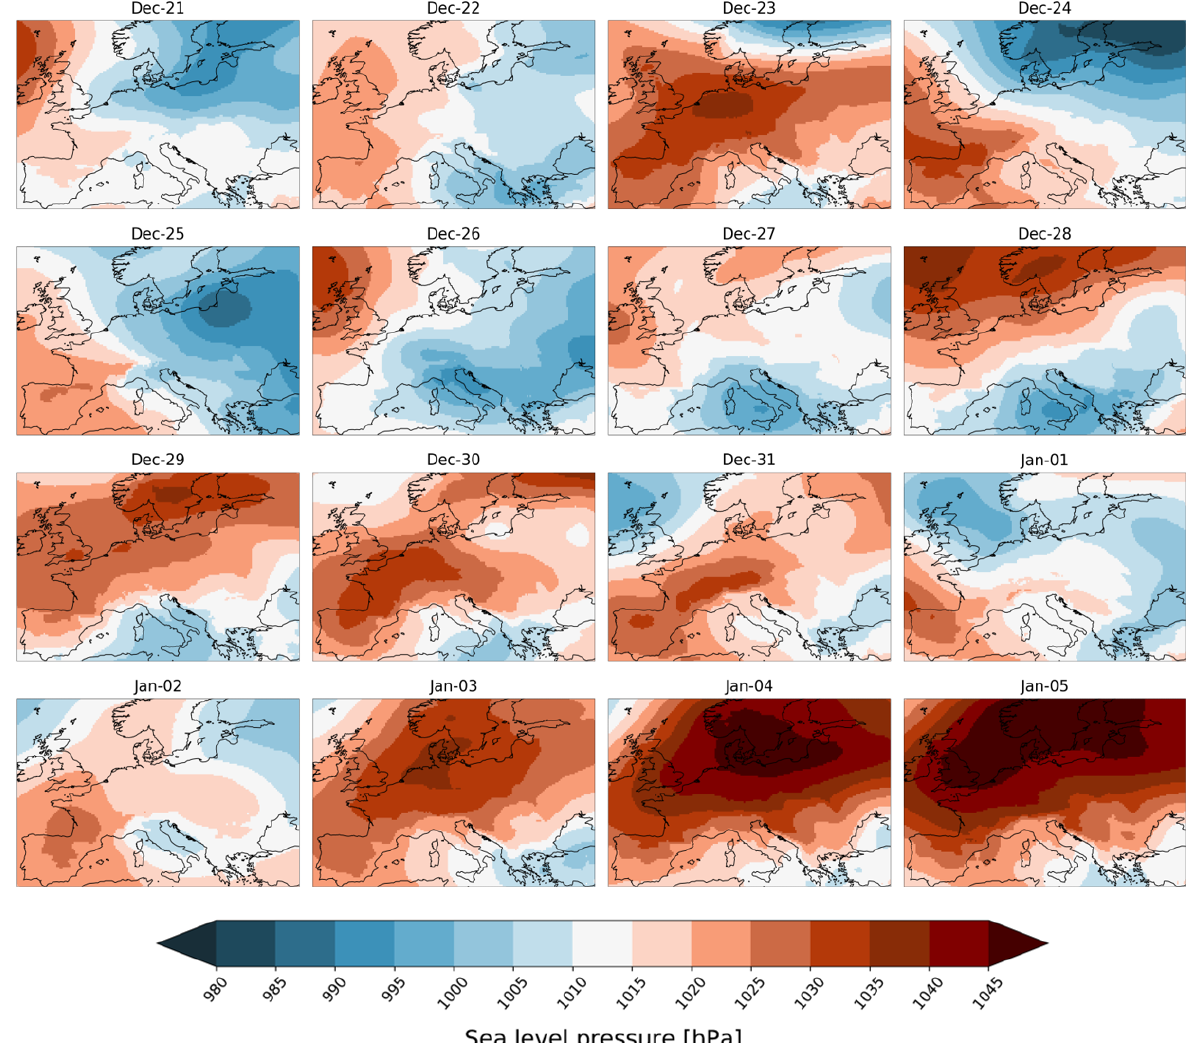
Figure 7. Daily mean sea level pressure fields over Europe (hPa) from the EnKF reconstruction covering the days from 21 December 1788 to 5 January